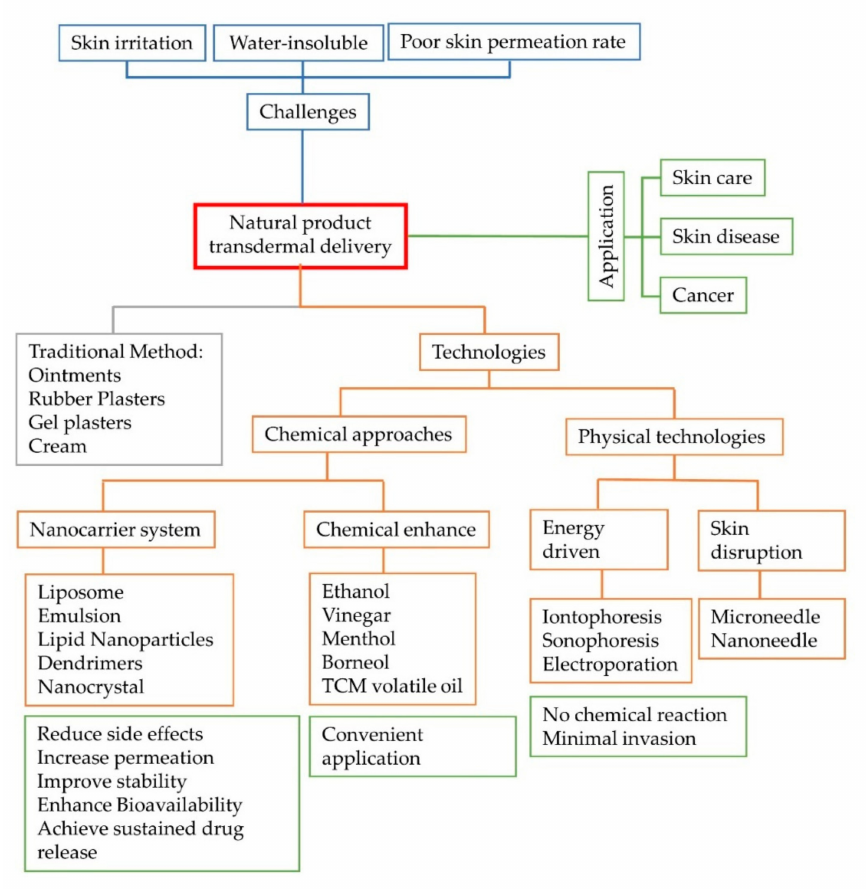
Figure 1. The applications, challenges, and technologies of natural product delivery on human